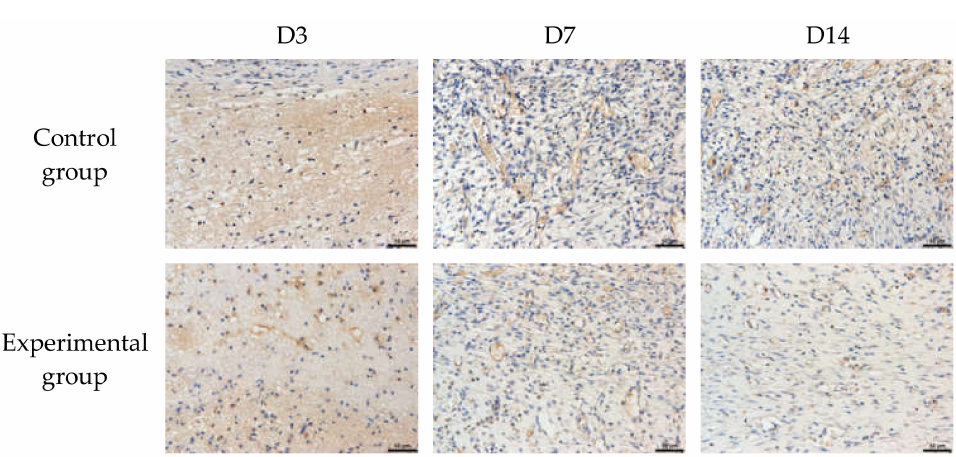
Figure 10. CD31 immunohistochemical staining